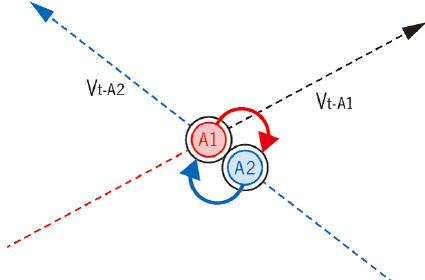
Fig. 14. AAs' original guidance to drive robots to the target positions: exchange of robots.